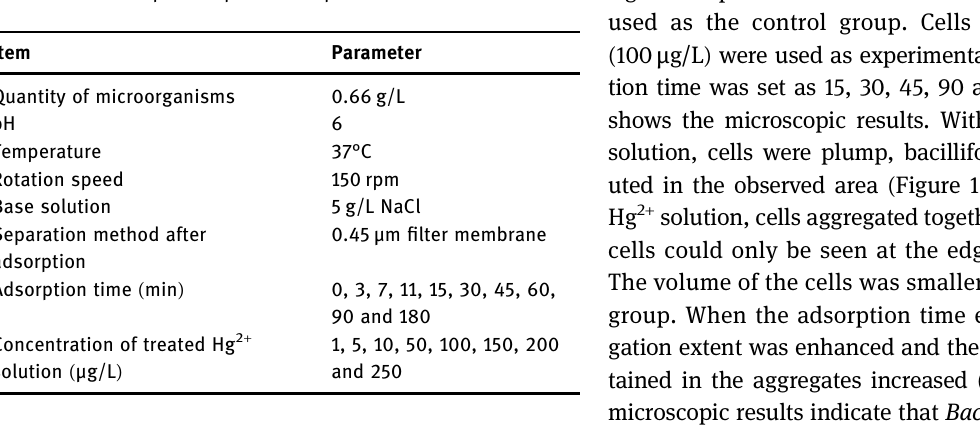
Table 1: The adsorption experimental parameters